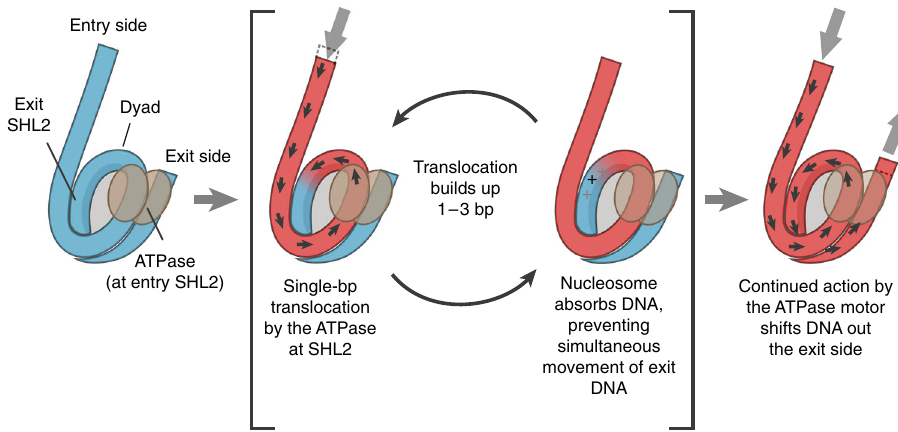
Fig. 4 A model for nucleosome sliding by Chd1 and ISWI. The remodeller ATPase (brown), located at SHL2, initiates nucleosome sliding on un-shifted DNA (blue). Cycles of hydrolysis translocate DNA at the SHL2 site, drawing DNA onto the entry side of the nucleosome and pushing DNA towards the exit side in ~1 bp steps (shifted DNA shown in red). While some segments of nucleosomal DNA immediately twist to convey the additional bp, other segments absorb the translocated DNA, resulting in local twist defects ( + ) on the nucleosome. Creation of these twist defects delays the movement of DNA to the exit